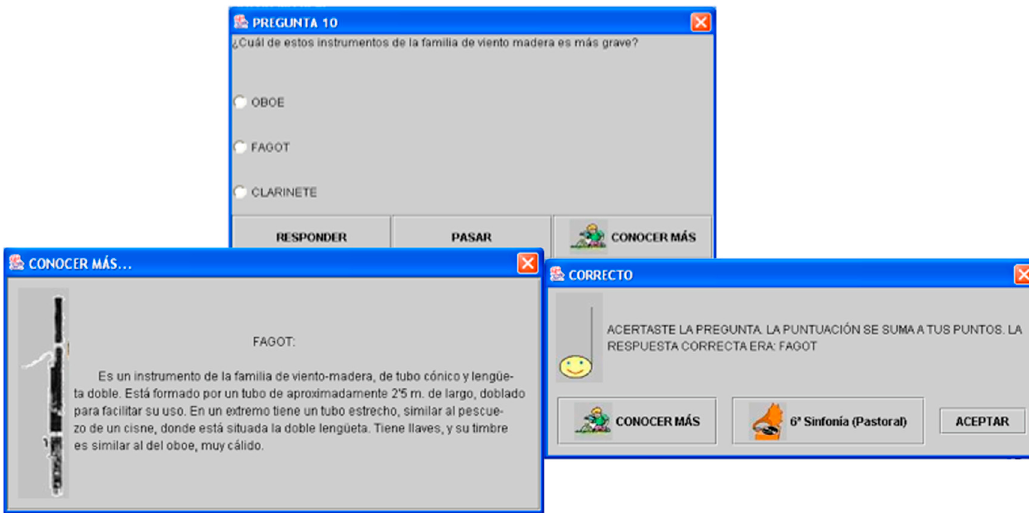
Figure 3. Example of the questions about musical instruments with the option “CONOCER MÁS and ESCUCHAR” (know more and listen).